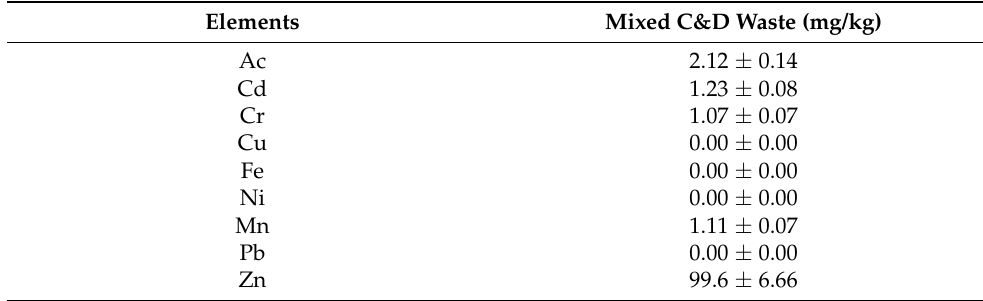
Table 3. Toxic elements in the mixed C&D